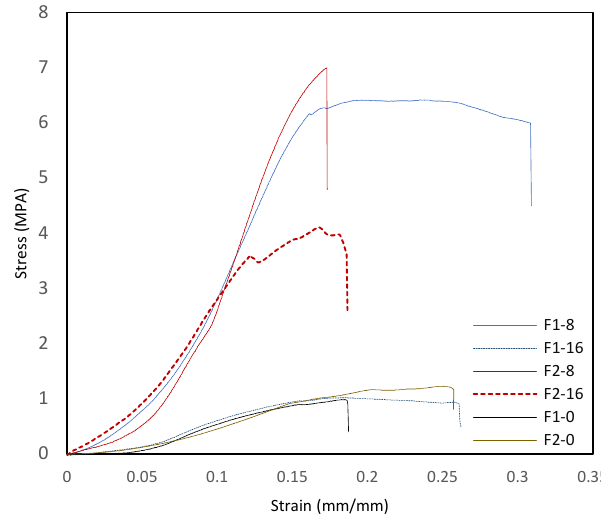
Figure 7. A representative stress-strain curve recorded from tensile test of composite films from ASC-g-P(MMA-co-EA) with/without GO contents.